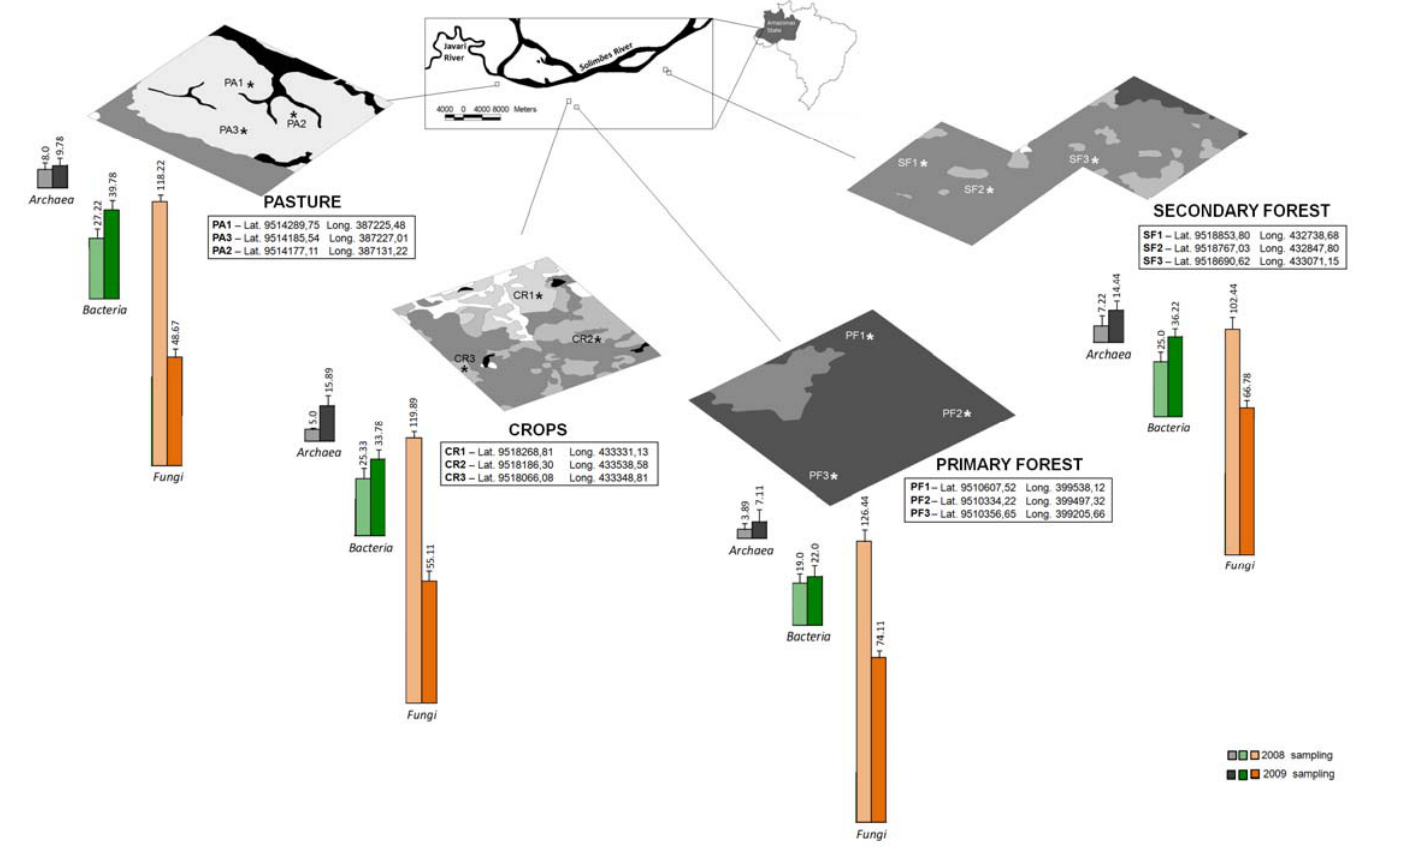
Figure 1. Operational taxonomic unit richness based on intergenic spacer region length polymorphisms of the rRNA gene detected using automated ribosomal intergenic spacer analysis (ARISA). The maps show the four sampling windows located in an Amazonian landscape (Benjamin Constant municipality, Amazonas State, Brazil, along the Solimões River). The colors represent different land use systems: primary forest ( ), secondary forest ( ), crops ( ), pasture ( ), water ( ) and exposed soil ( ). Soil samples were collected at different points ( ), at a depth of 0–20 cm from sites representing primary tropical rain forest, traditional crops systems of the indigenous people, pasture and * secondary forest over a two-year sampling (March 2008 and January 2009). The richness values were calculated based on triplicate PCR products from the soil